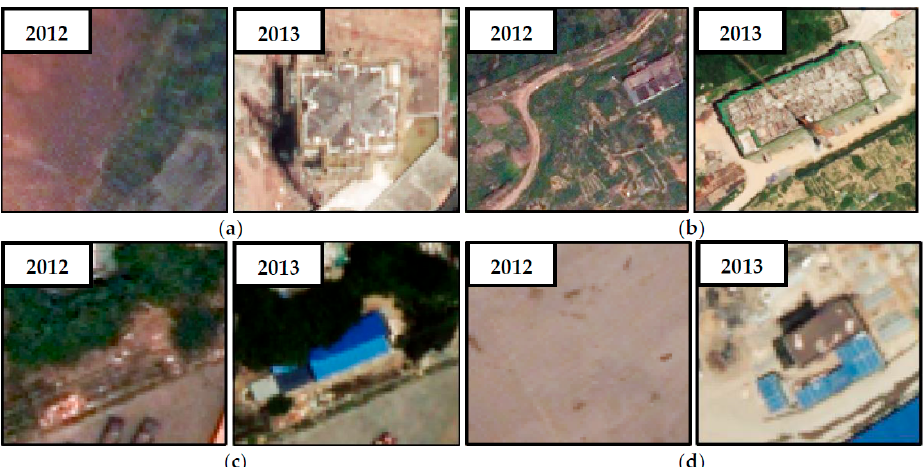
Figure 17. Examples of missing changes in Dataset 1: ( a ) missed detection caused by imperfect change information, ( b ) missed detection caused by ineffective semantic segmentation for the buildings under construction, ( c ) missed detection caused by serious sheltering of small buildings in the peripheral environment, and ( d ) missed detection caused by improper filtering of the shanties with a few pixels.